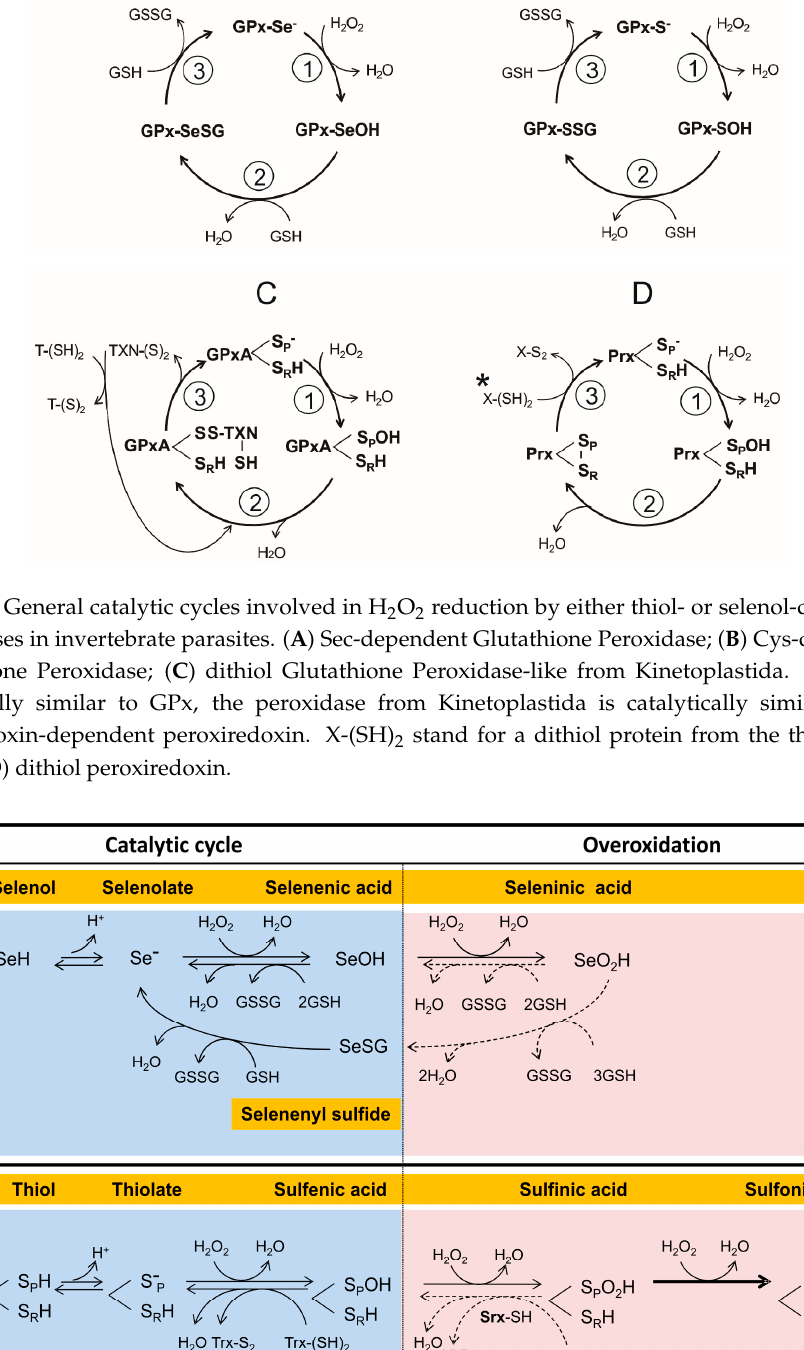
Figure 5 . Mechanisms involved in the overoxidation of the catalytic Sec or Cys in representative enzymes. Both the catalytic and the overoxidative pathways in a Sec-dependent Glutathione Peroxidase ( A ), and in a Cys-dependent peroxiredoxin ( B ) are detailed. The different oxidation states for both Sec and Cys are shown. Reversible reactions in the overoxidative pathways are indicated by dotted lines. Abbreviations are as follows: sulfiredoxin (Srx); reduced thiol-dependent substrate (XSH); disulfide form of a thiol-dependent substrate (XSSX).